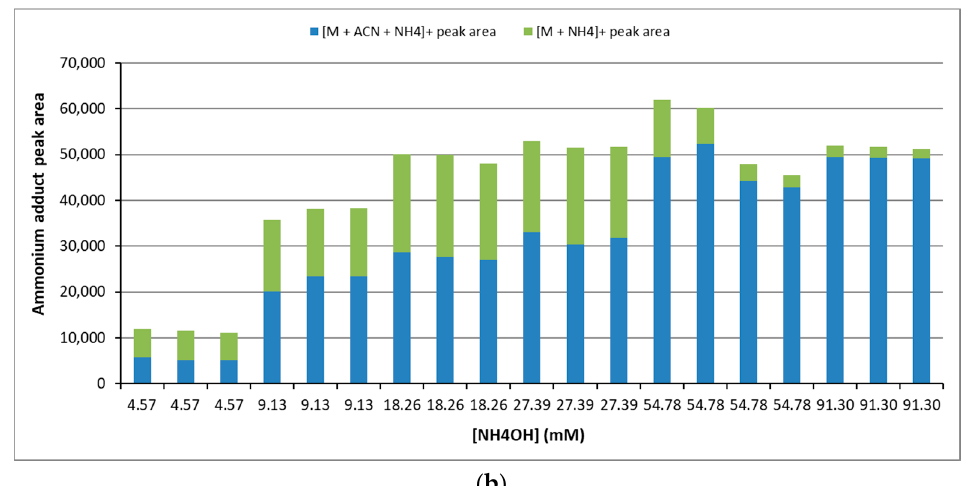
Figure 4. Chromatographic peak area of the adducts formed at different concentrations of NH 4 OH ( a ) for TAG(17:0/18:1/17:0) and ( b ) for TAG(14:0/18:1/22:0). Green triangles, [M + NH 4 ] + adduct; blue diamonds, [M + ACN + NH 4 ] + adduct; red triangles, sum of the two adducts; blue line, polynomial trend of [M + ACN + NH 4 ] + adduct formation (see Supplementary Information for further details). ACN means acetonitrile.